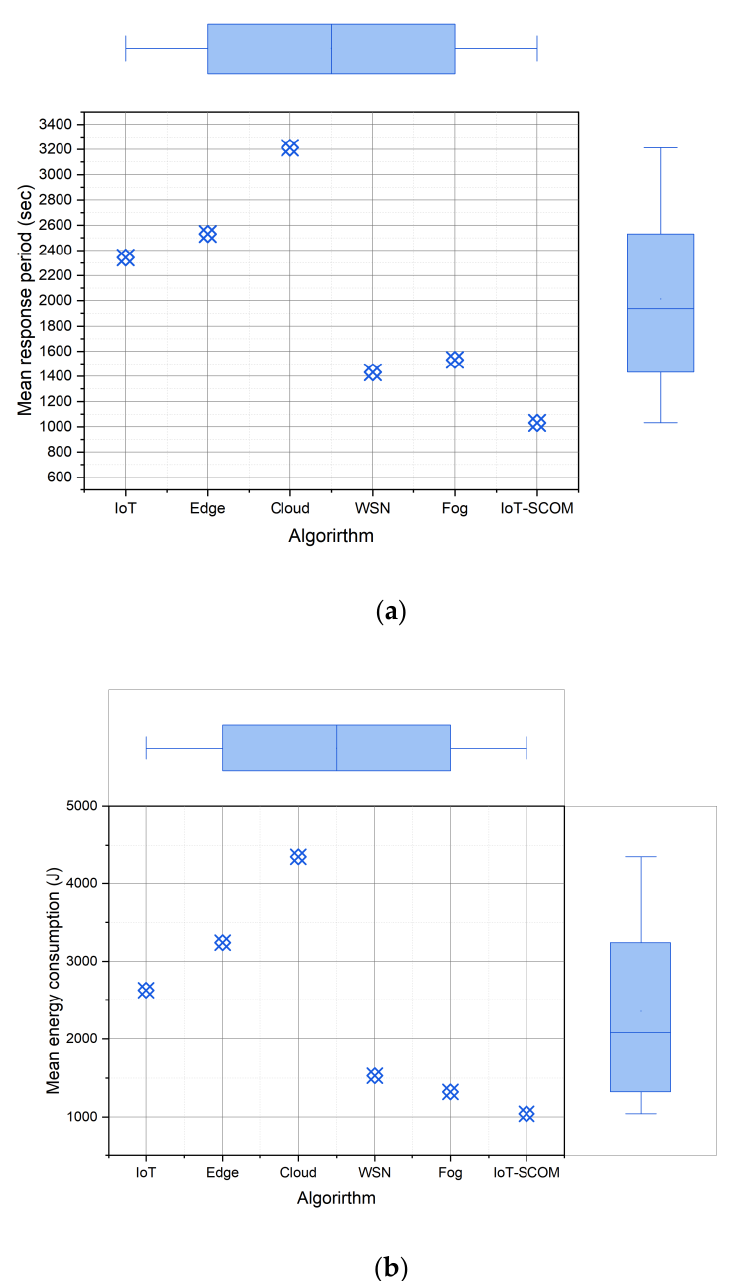
Figure 8. ( a ) Mean response period analysis, ( b ) Mean energy consumption analysis. The performance of the ant colony optimization algorithm is compared with the existing MEC-AIoT [21], and LWLR [18] is shown in Table3.